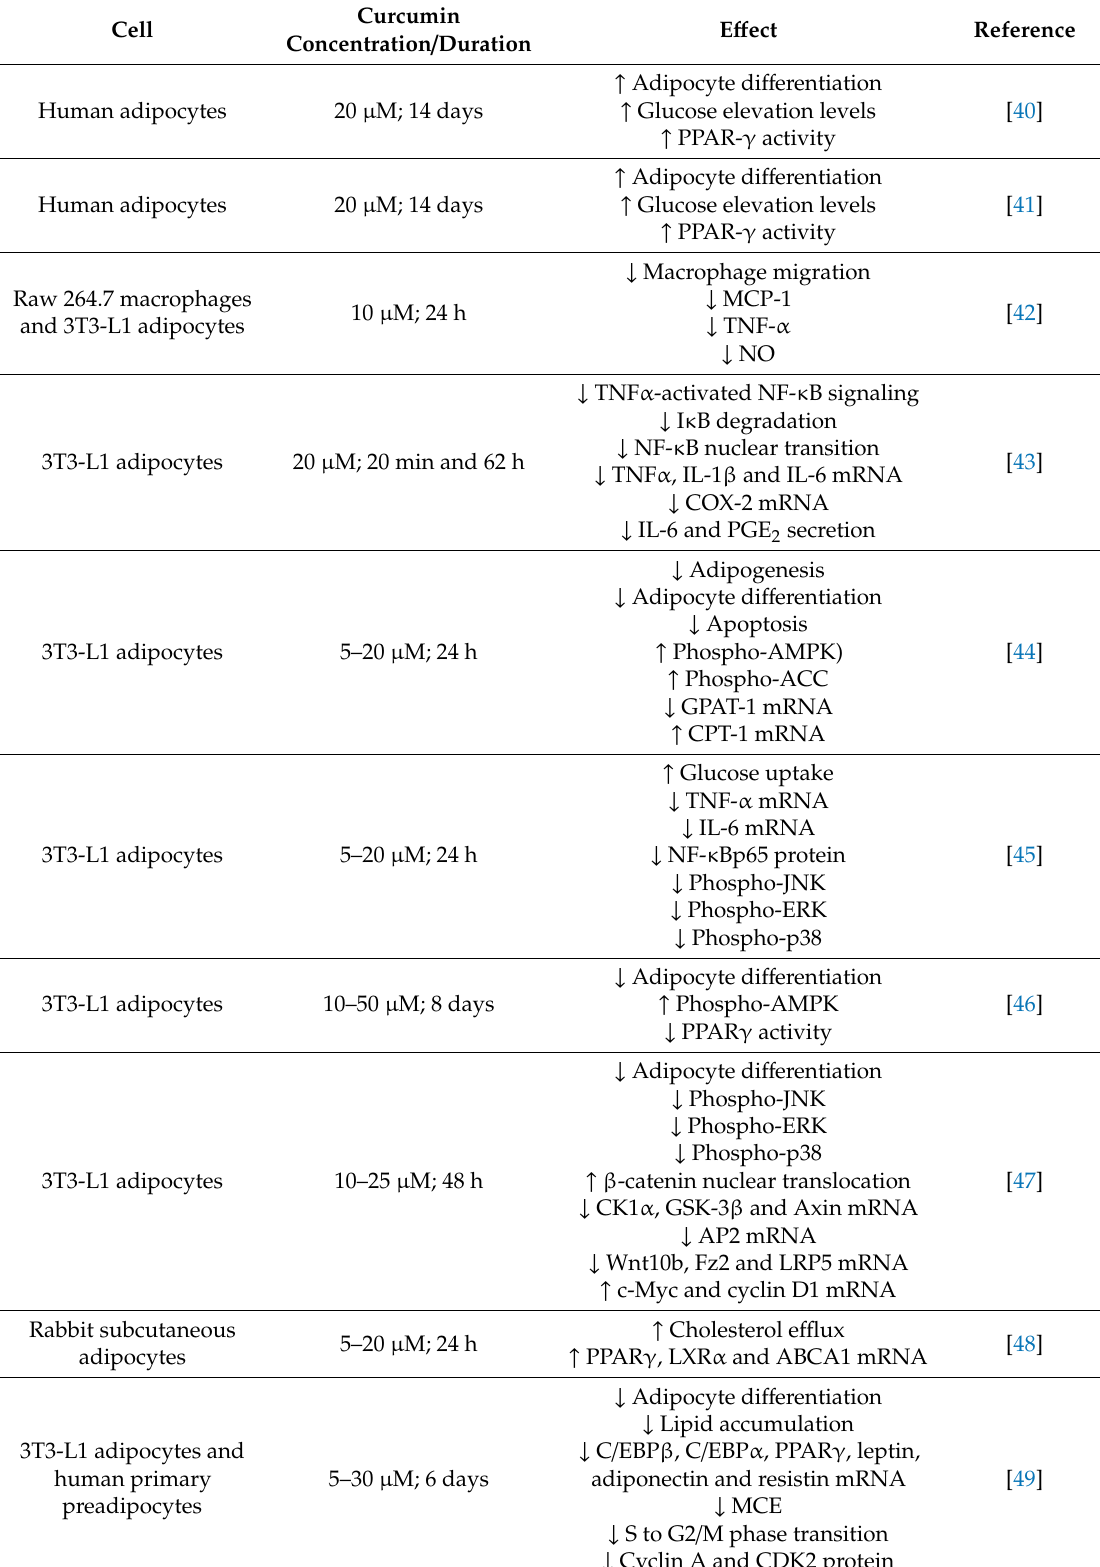
Table 1. E ff ects of curcumin: in vitro adipocyte